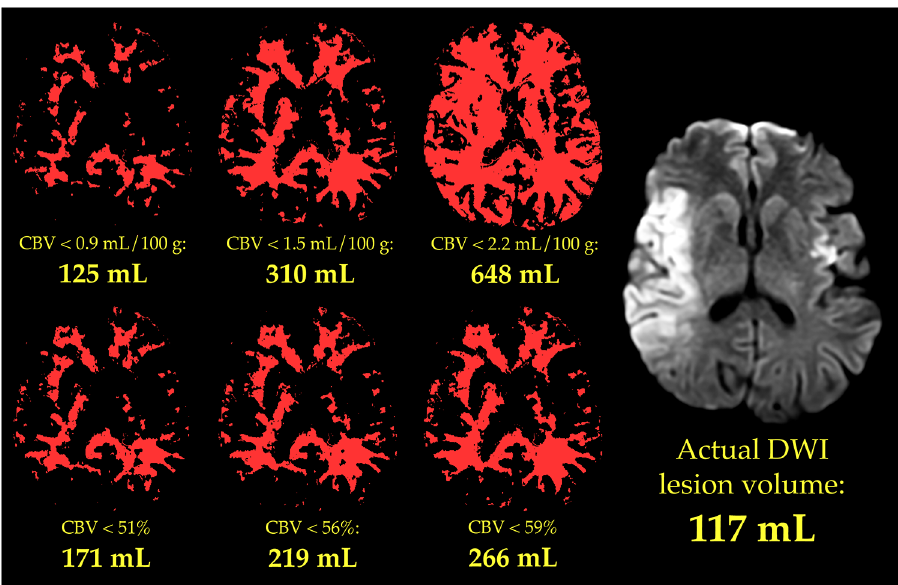
Fig 1. Objective measurement of CBV lesion volume. The six smaller images depict low-CBV lesions that were delineated automatically, in a single slice of one patient ’ s CBV maps, by rendering in white all brain pixels in which CBV was below each of six different thresholds. Each threshold is listed below its corresponding image, along with the total volume of tissue with CBV below that threshold in all slices. For clarity, the lesions identified by only three of the six absolute thresholds are shown in the top row, and lesions identified by only three of the six relative thresholds are shown in the bottom row. The larger image on the right is a DWI image obtained from the same patient, at approximately the same level. The gold standard core volume, measured over all DWI slices, was 117